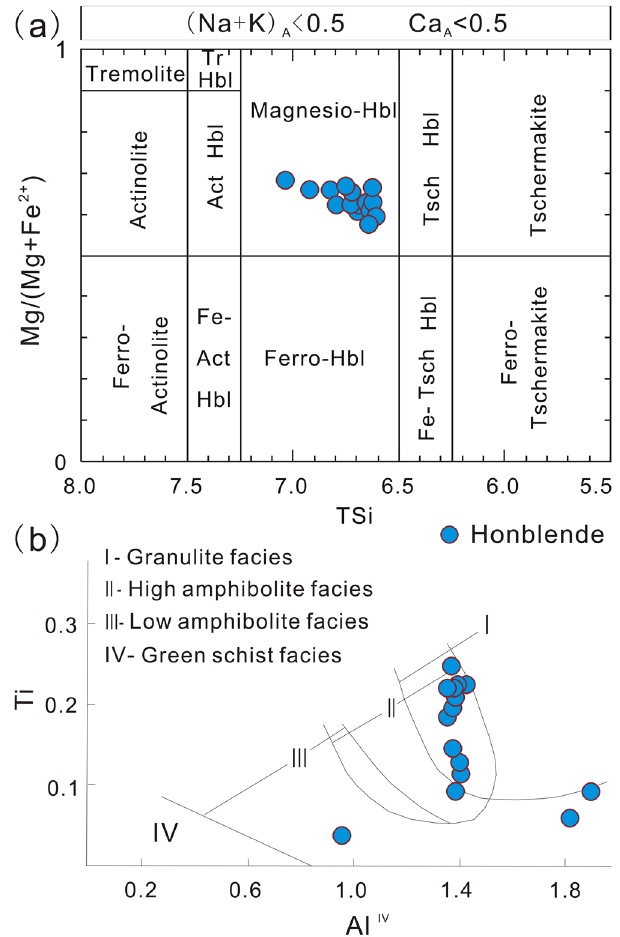
Figure 5. Amphibole chemistry from the hornblendite. ( a ) Si-Mg/Mg + Fe 2 + (after Leak et al . 53 ); ( b ) Al-Ti diagram (after Jin 54